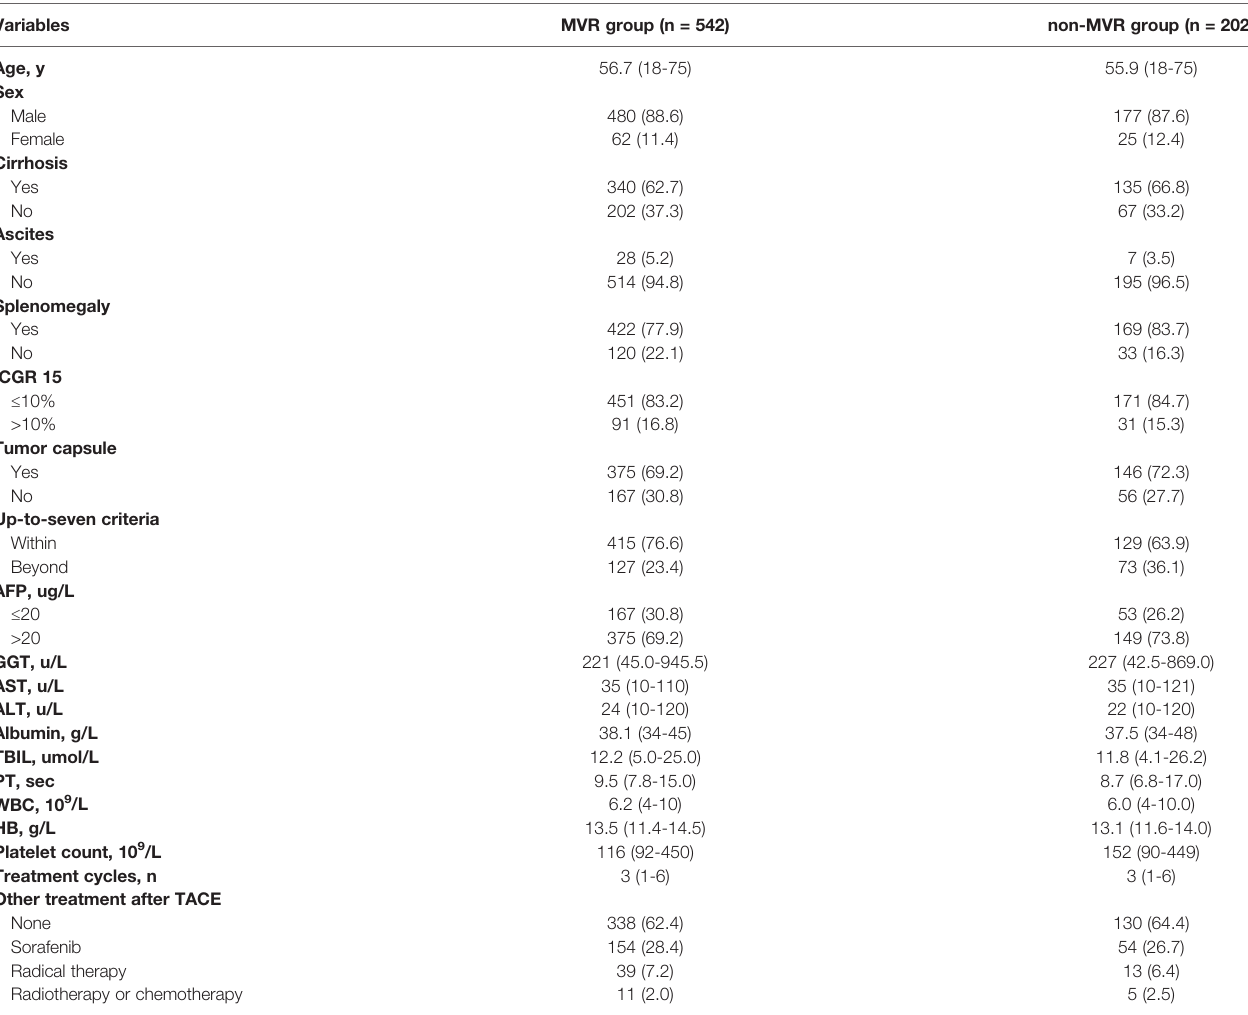
TABLE 3 | Baseline characteristics of patients received NA therapy achieving VR (MVR versus